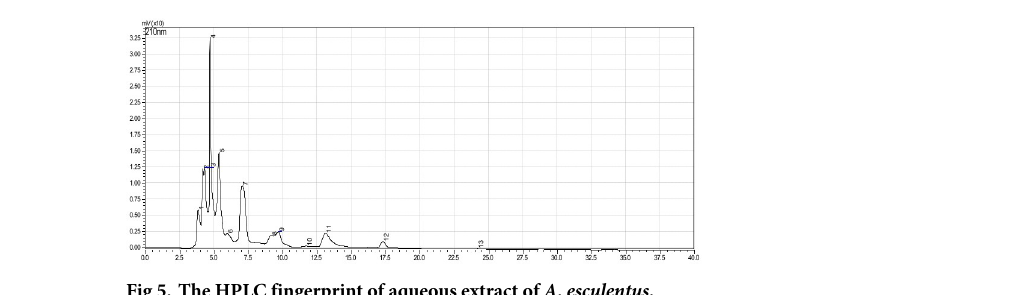
The oral administration of the AEFE at doses 100 mg/kg and 200 mg/kg significantly reduced fasting plasma glucose at day 7 and day 14 ( P < 0.001). The reduction of fasting plasma glucose was more (6.0 ± 0.61) mmol/L in a group given 200 mg/kg compared to that received 100 mg/ kg (6.5 ± 0.37) mmol/L. However, the observed difference in response between the two doses was not statistically different ( P = 0.467). There was no statistically significant difference in mean fasting plasma glucose at day 14 between the groups receiving polyphenolic-rich extract and standard Glibenclamide ( P > 0.05). Table 6 illustrates the various comparisons. Using the sigmoid dose-response equation, the EC50 of the extract was calculated as 141.4 mg/kg.